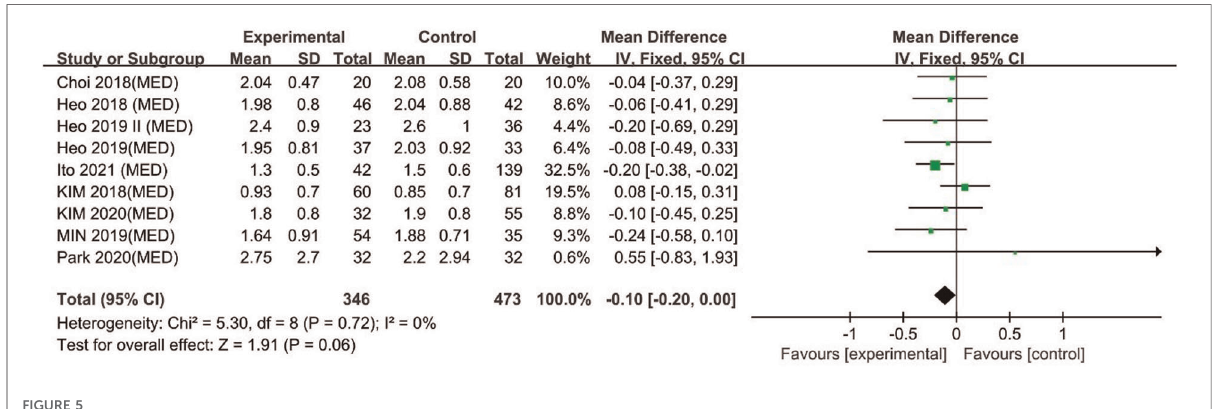
FIGURE 5 Forrest plot of long term vas back pain UBE vs